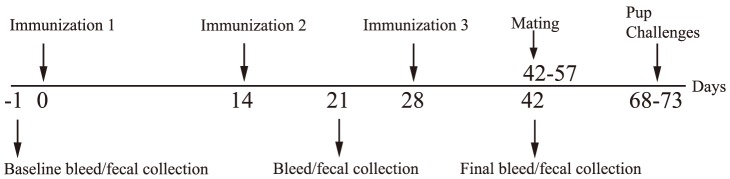
Mouse procedures timeline.Female CD-1 mice were immunized 3 times at 14-day intervals by the IP route starting at day 0. Blood and fecal samples were collected on days −1, 21, and 42. Following the final bleed, the females were mated 1-to-1 with 12-week old male CD-1 mice. The females were monitored for birth and 6-day old pups were used for challenge with live V. cholerae N16961.